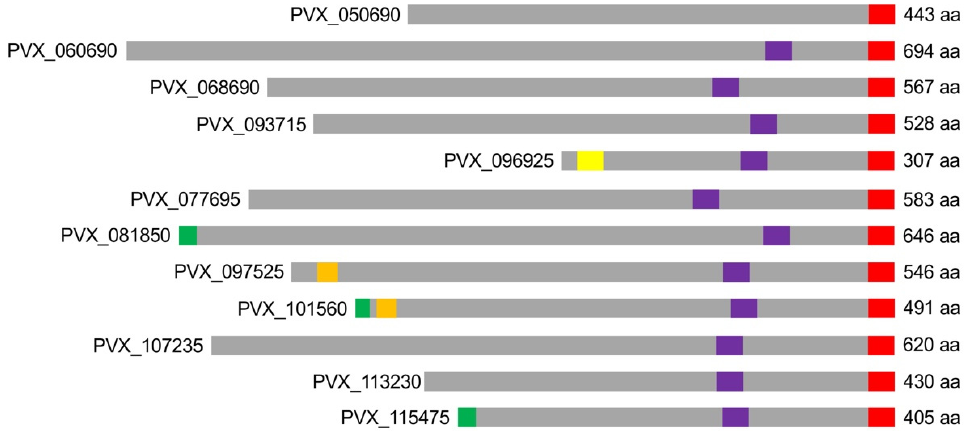
Figure 1. Schematic representation of the VIR proteins whose corresponding encoding vir genes were expressed in P. falciparum (aa: amino acids; red: HA-tag; purple: putative transmembrane domain; yellow: PEXEL motif; orange: PEXEL-like motif; green: mature N-terminus).